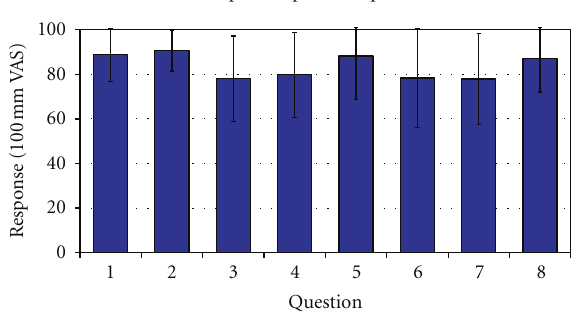
Figure 2: Participant Satisfaction Questionnaire (error bars indi- cate mean ± 1 standard deviation). High scores indicate a more favourable response than low scores. Questions: (1) how easy was the finger device and headset to operate?; (2) how easy was the device to attach to your finger?; (3) how comfortable was the device during the exercise program?; (4) could you see the physiotherapist clearly during the exercise session?; (5) could you hear everything that was being said?; (6) how confident are you in using technology in general?; (7) how interested are you in learning about new technology?; (8) would you feel confident using this device at home?